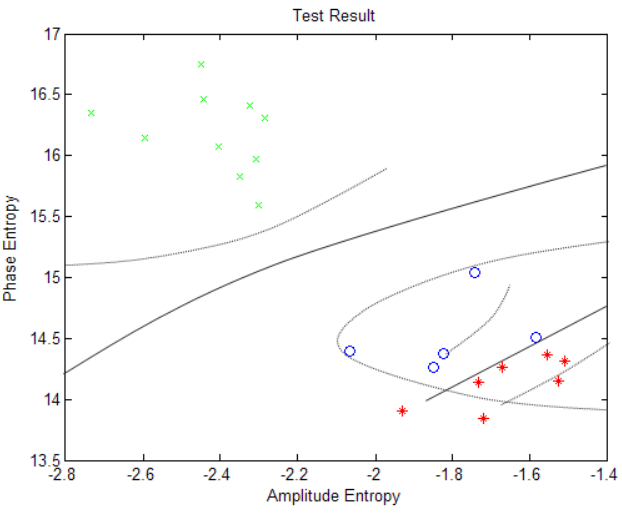
Figure 8. The test results of IPSO-SVM